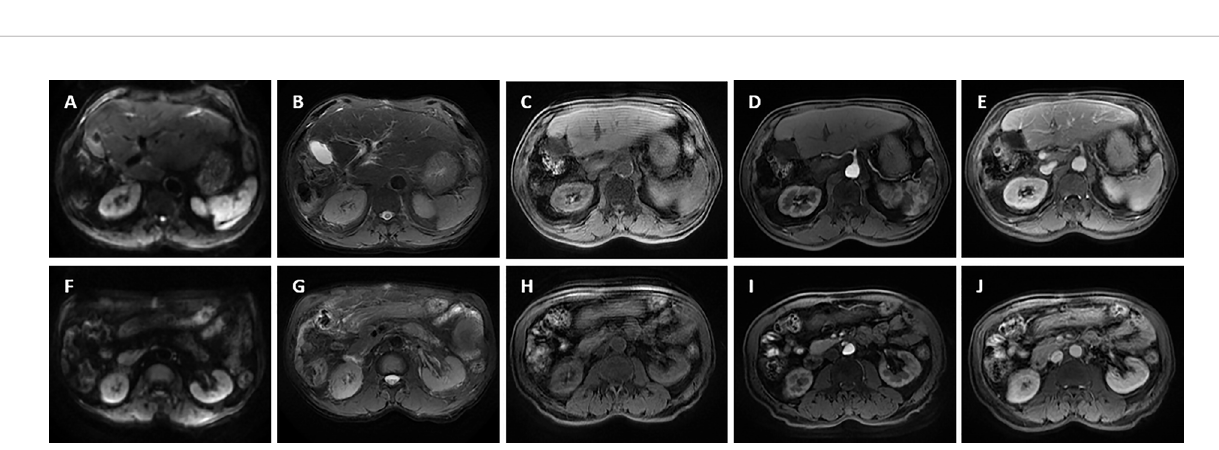
FIGURE 9 | Magnetic resonance imaging was performed for the patient after four cycles of postoperative adjuvant chemotherapy. The tumor has disappeared without recurrence. (A, F) Diffusion-weighted imaging (DWI); (B, G) T2-weighted imaging; (C, H) T1-weighted imaging; (D, I) The arterial phase; (E, J) The delayed